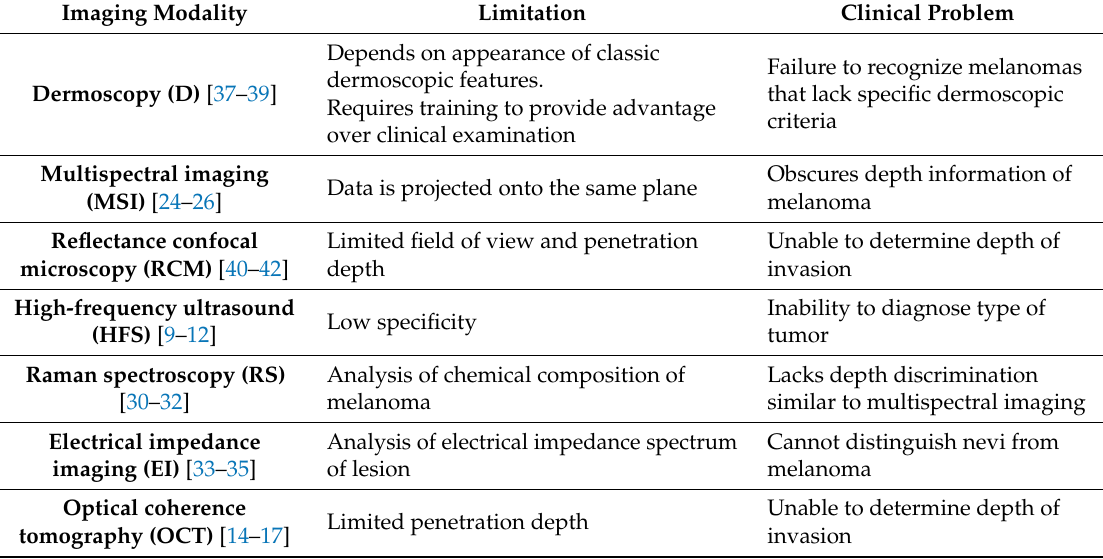
Table 1. Limitations of non-invasive melanoma imaging